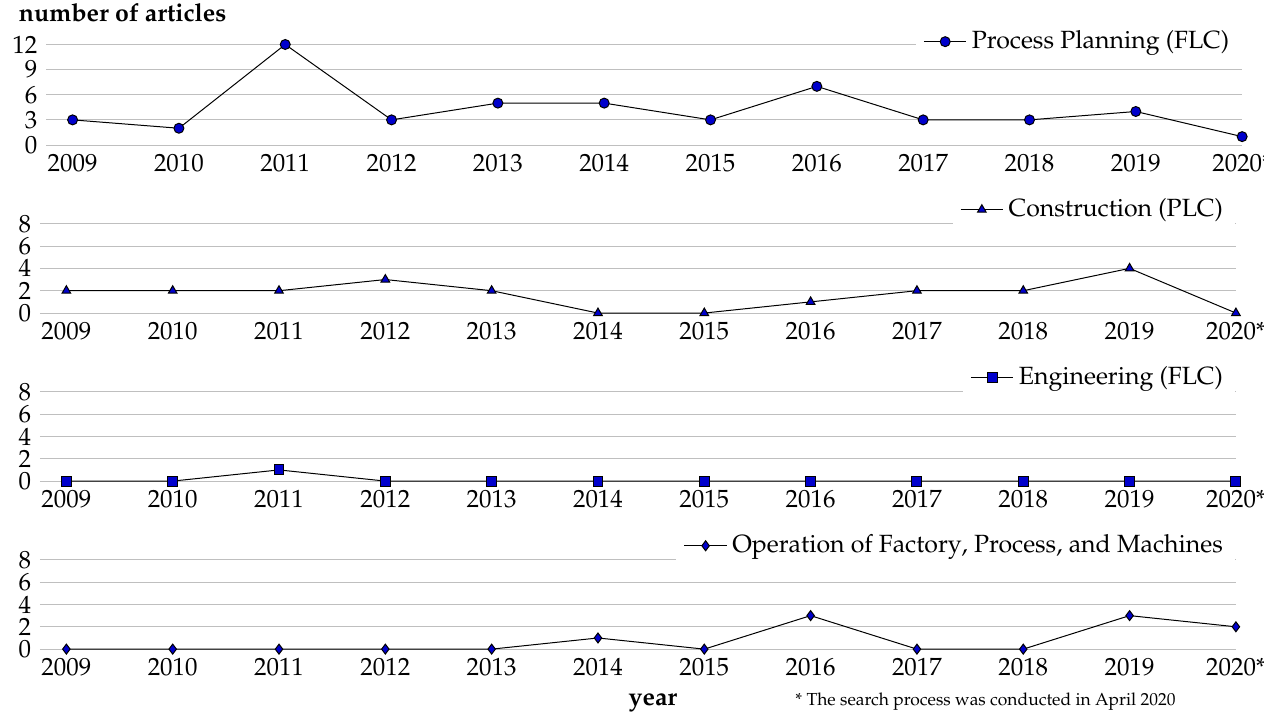
Figure 8. Number of articles over time for the category